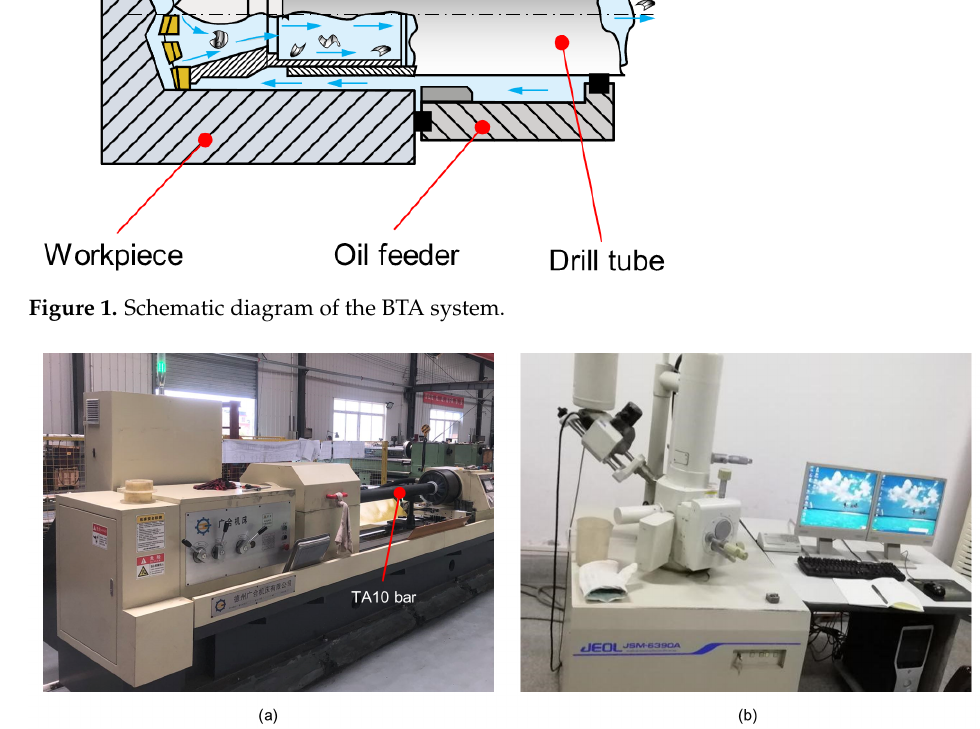
Figure 2. Processing environment and experiment equipment. ( a ) T2120G deep-hole drilling and boring machine (Dezhou, China); ( b ) scanning electron microscope JSM-6390A (Akishima,